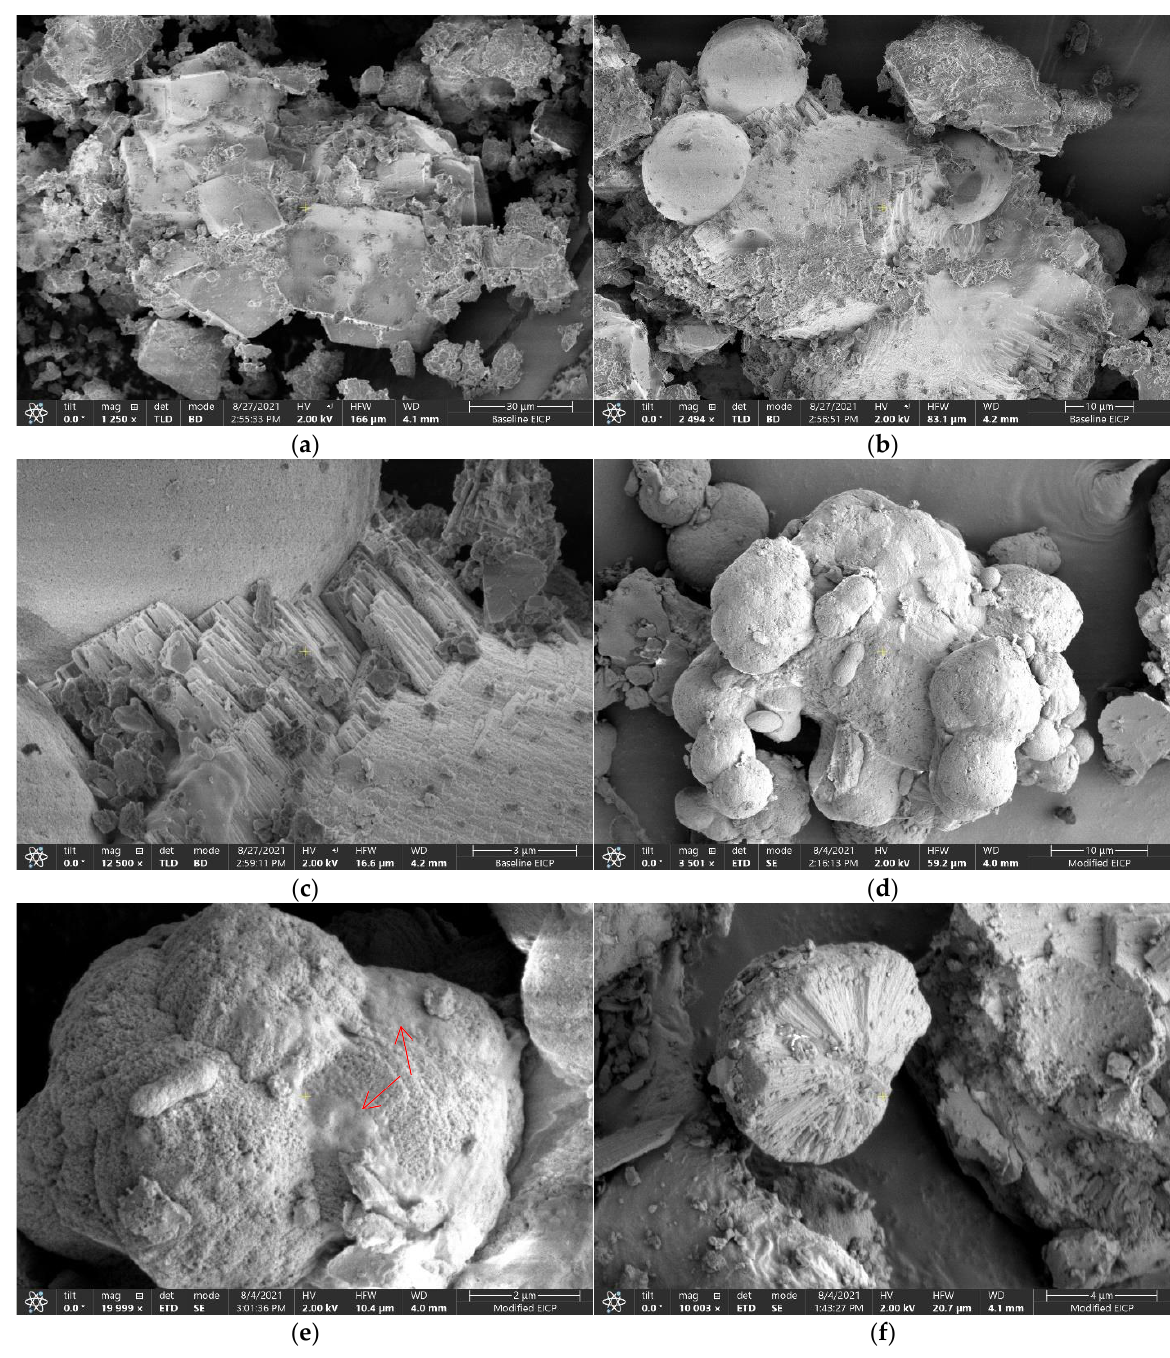
Figure 1. ( a – c ) SEM images of the baseline precipitate: ( a ) Imbricated rhombohedral clusters of calcite polycrystals. Smaller overgrown crystals are observed predominantly along corners and edges of the calcite crystal substrate. ( b ) Elongated (with curved surfaces) and spherulitic calcite crystals. ( c ) Magnified image of ( b ) showing overgrown needle fiber calcite. ( d – f ) SEM images of the modified precipitate: ( d ) Aggregate of spherulitic calcite crystals. ( e ) Coalesced calcite spherulites at higher magnification. Deposits of organic solids (from milk, urease source) are observed on the grain (red arrows). ( f ) Broken particle of spherulitic calcite or vaterite. Radial groove-like features can be seen in the interior section of the particle.